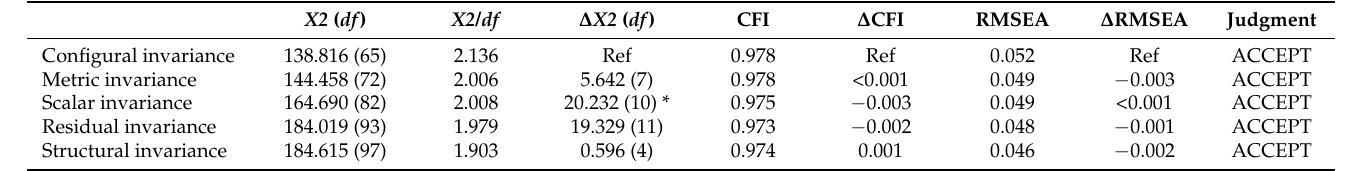
Invariances of the mediation models across groups using Multi-group Structural Equation